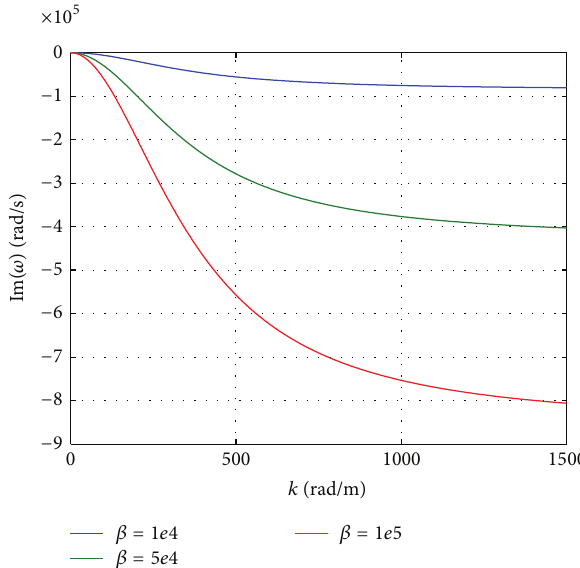
Figure 5: Angular frequency (imaginary part) versus frequency for three damping coefficients 𝛽